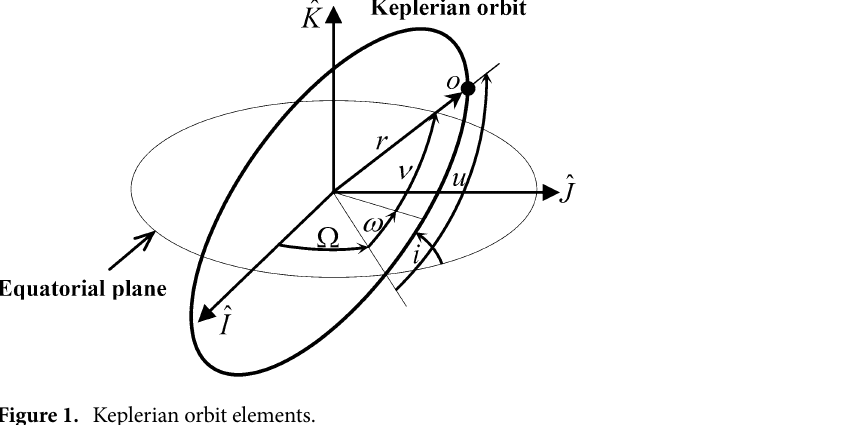
Figure 1. Keplerian orbit